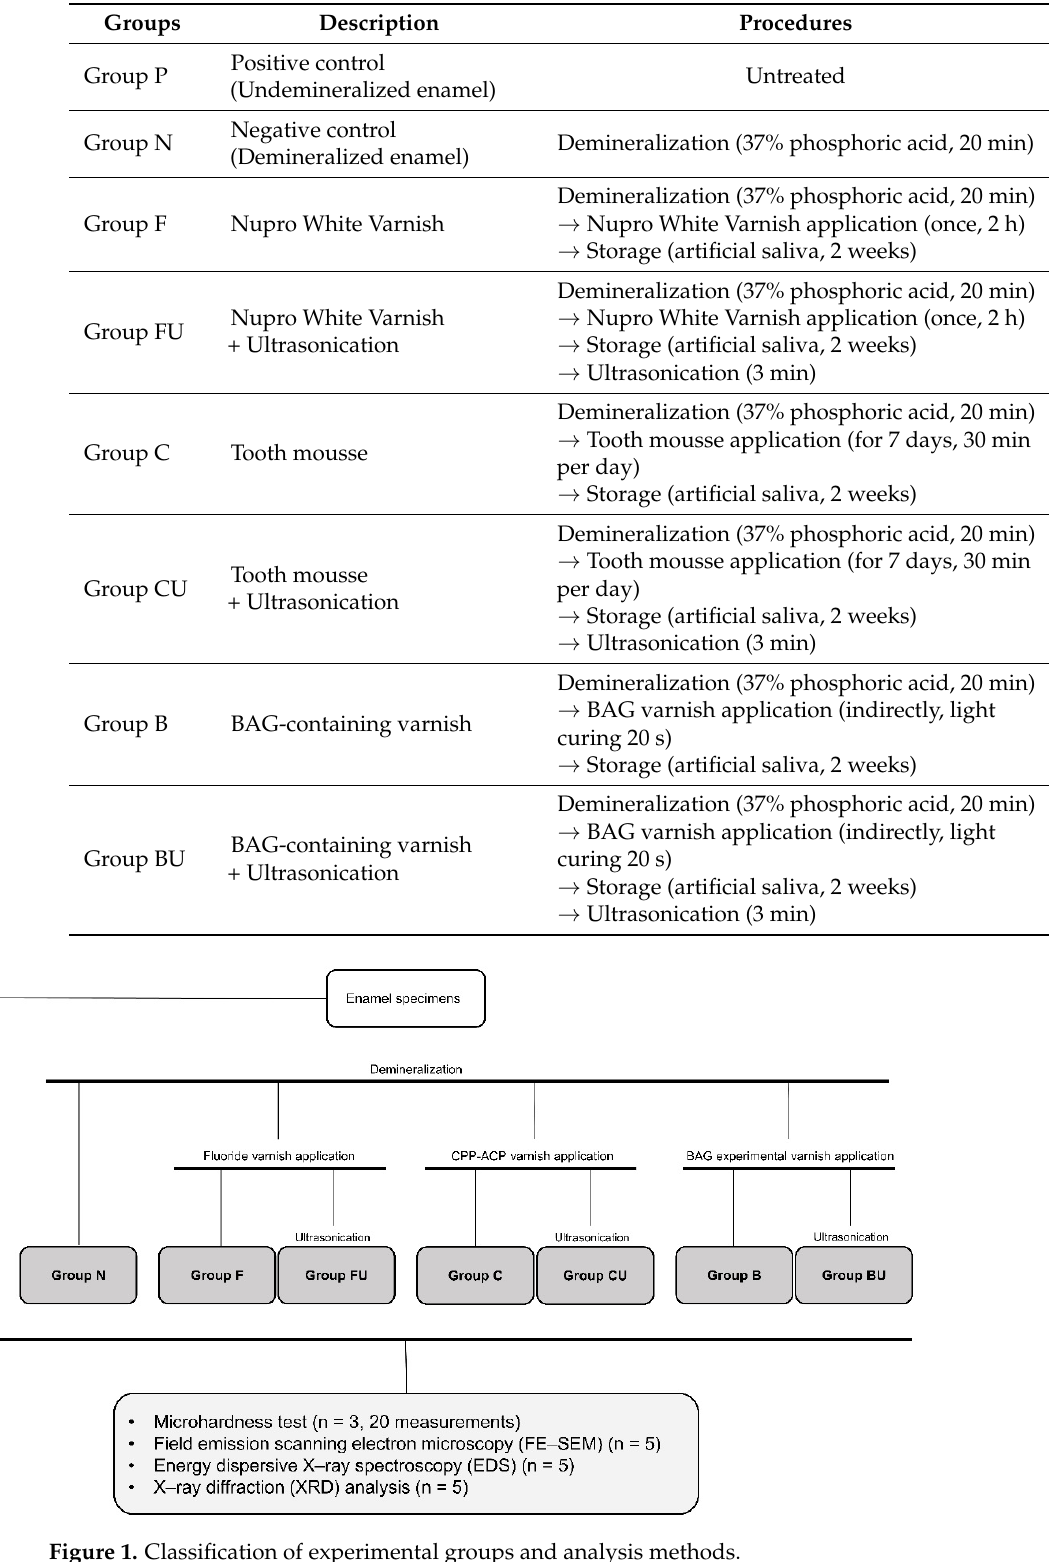
Table 2. Protocol for each experimental group.